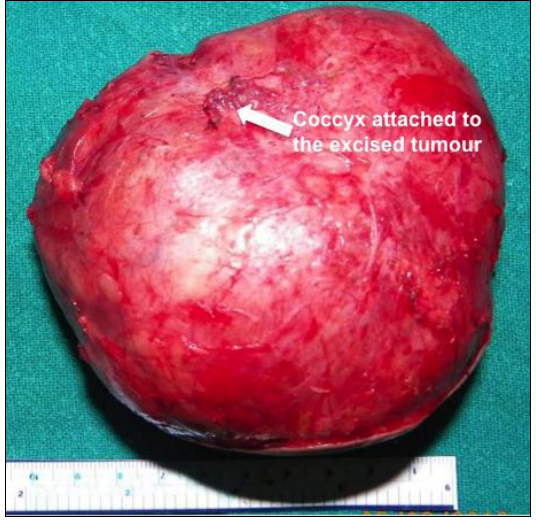
Figure 2: Excised